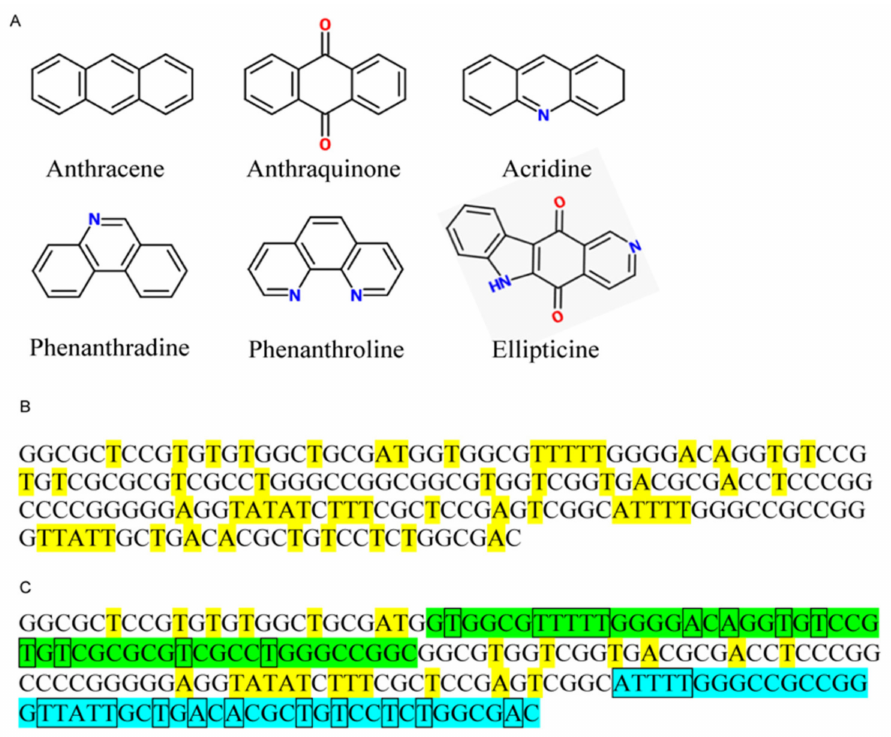
Figure 1. Structural precursors to common DNA intercalating compounds and the sequence arrange- ment of the rDNA promoter region. ( A ) All currently available intercalating compounds derive from just six basic chemical structures. ( B ) Sequence of the human Pol-I promoter with all adenine and thymine residues highlighted (yellow). ( C ) Sequence of the human Pol-I promoter with the UCE (green) and core promoter (blue) are highlighted, with adenine and thymine residues within these regions